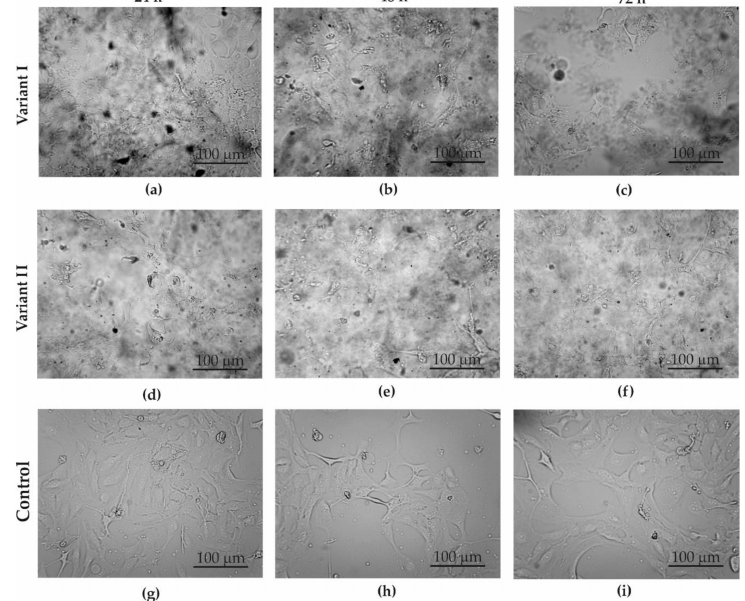
Figure 6. Optical microscope images of SW-954 cell culture in: ( a – c ) variant I; ( d – f ) variant II; ( g – i ) control; after: 24 ( a , d , g ), 48 ( b , e , h ), and 72 h ( c , f , i